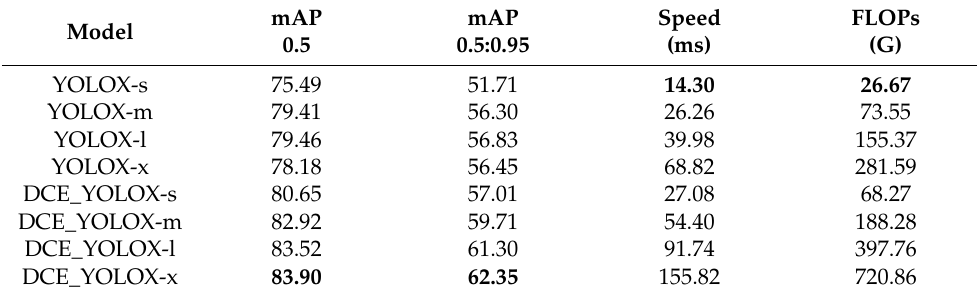
Table 3. Performance